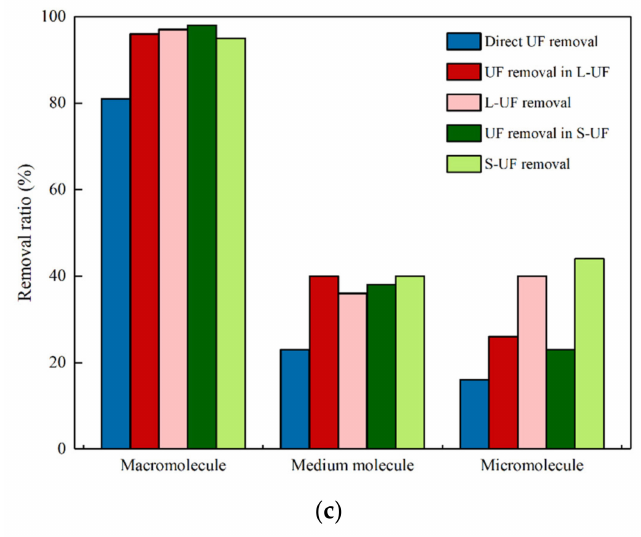
Figure 3. ( a , b ) MW variations of the mixed liquor in the L-UF reactor and S-UF reactor, and ( c ) removal ratio of different interval molecular